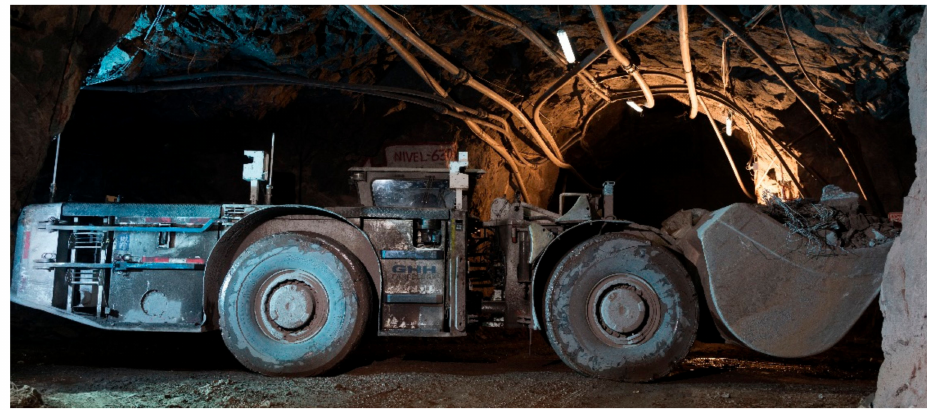
Figure 1. Full-scale LHD machine used during the test of the excavation algorithm.